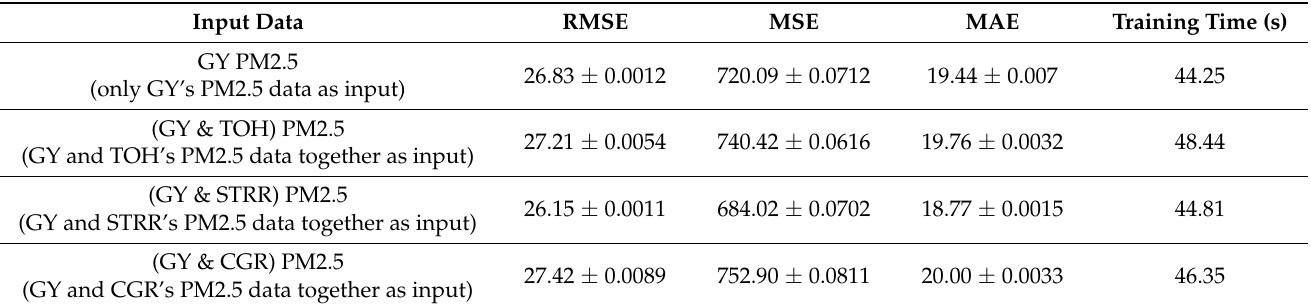
Table 2. Analysis of the forecasting results based on the historical data of PM2.5 in different regions as the input data of the network.